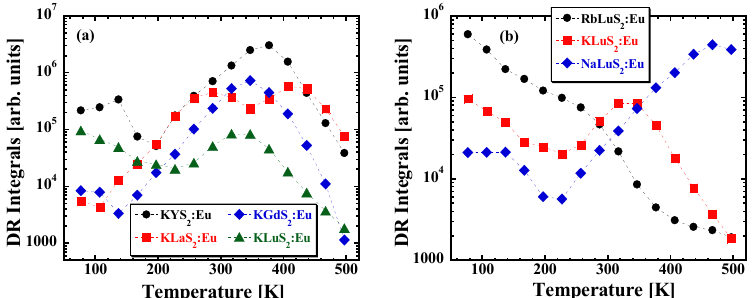
Figure 7. Temperature dependence (TD) of the delayed recombination (DR) integrals (excitation and emission wavelengths identical to those for nanoseconds decay time measurements, see Table 4) for ( a ) KLnS 2 :Eu (Ln = La, Gd, Lu, Y) and ( b ) ALuS 2 :Eu (A = Rb, K, Na); composition given in the legend.